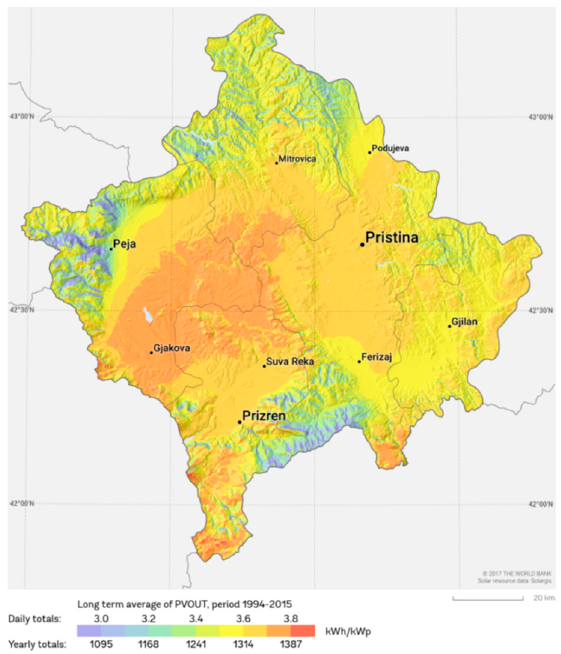
Figure 5. Global horizontal radiation in [kWh/m 2 ] [20].